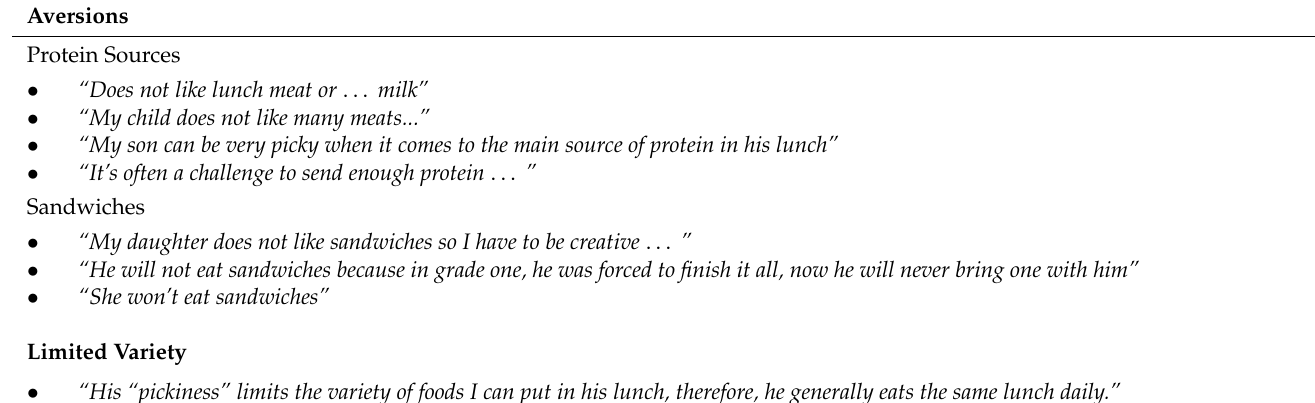
Table 5. Barriers related to picky eating that hindered parent’s ability to pack a school lunch for their child 1 . Aversions Protein